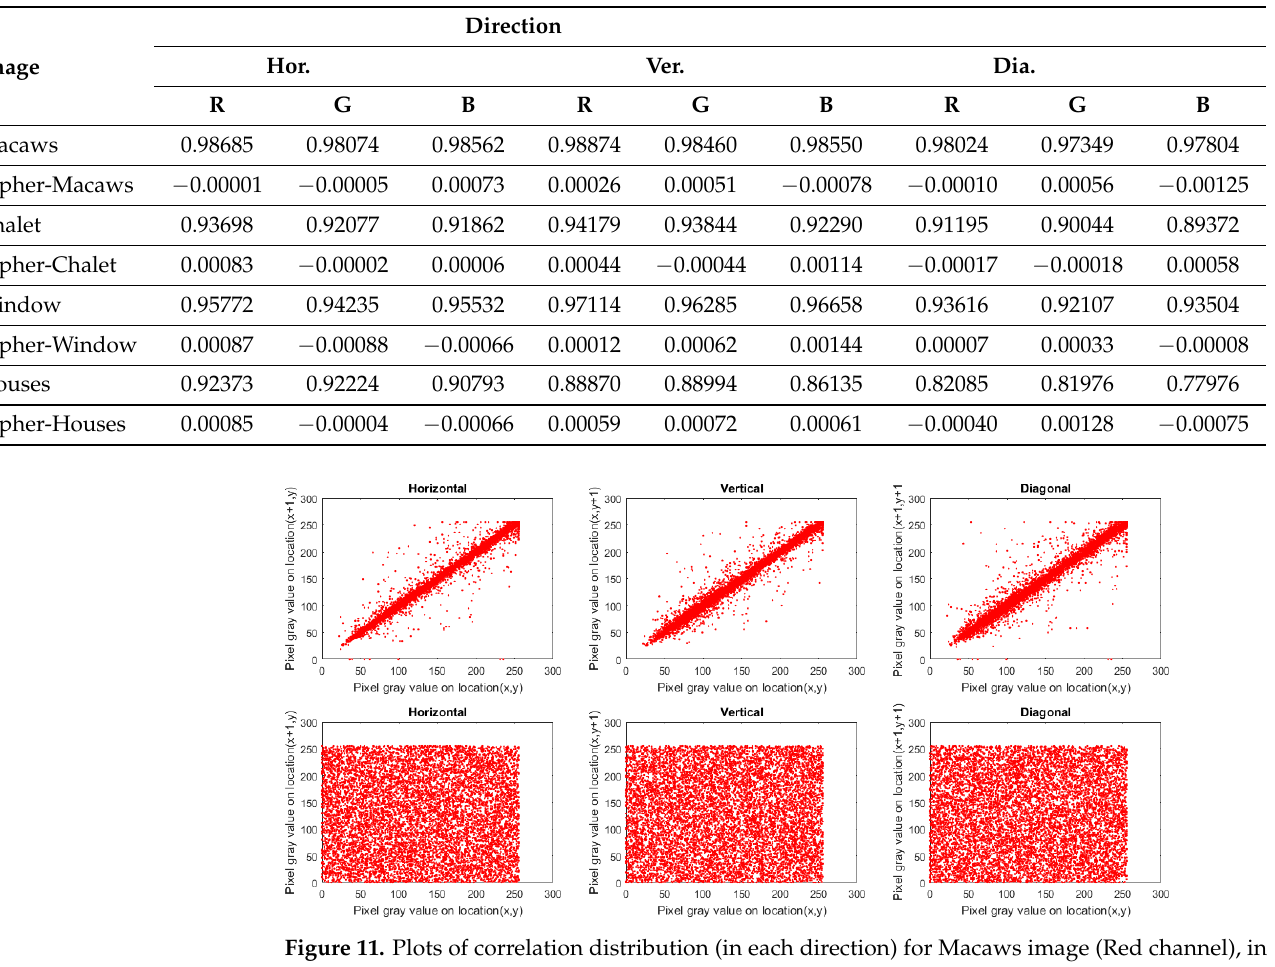
Figure 11. Plots of correlation distribution (in each direction) for Macaws image (Red channel), in which the first row denotes the plain Macaws image, while the bottom row signifies the ciphered Macaws image.